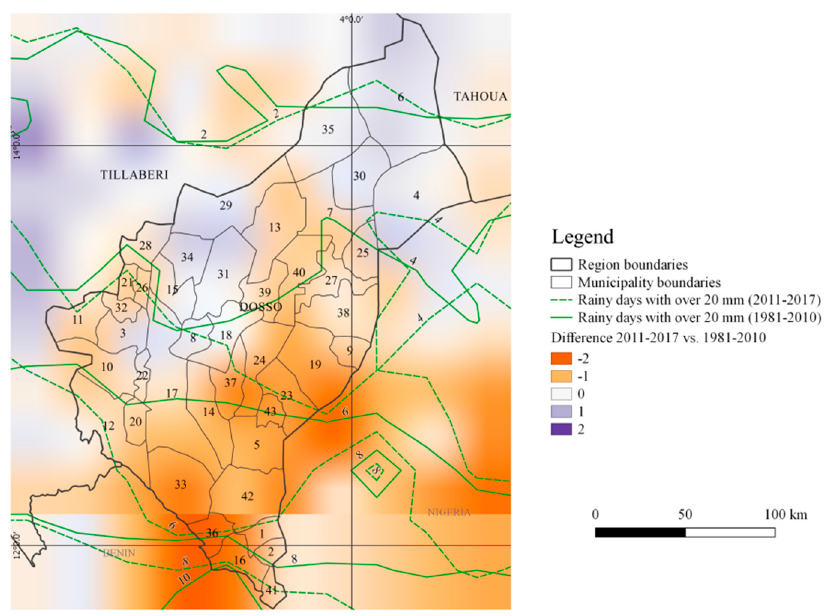
Figure 5. The difference in the average number of rainy days with over 20 mm in the 2011–2017 and 1981–2010 periods (rainfall data from CHIRPS).